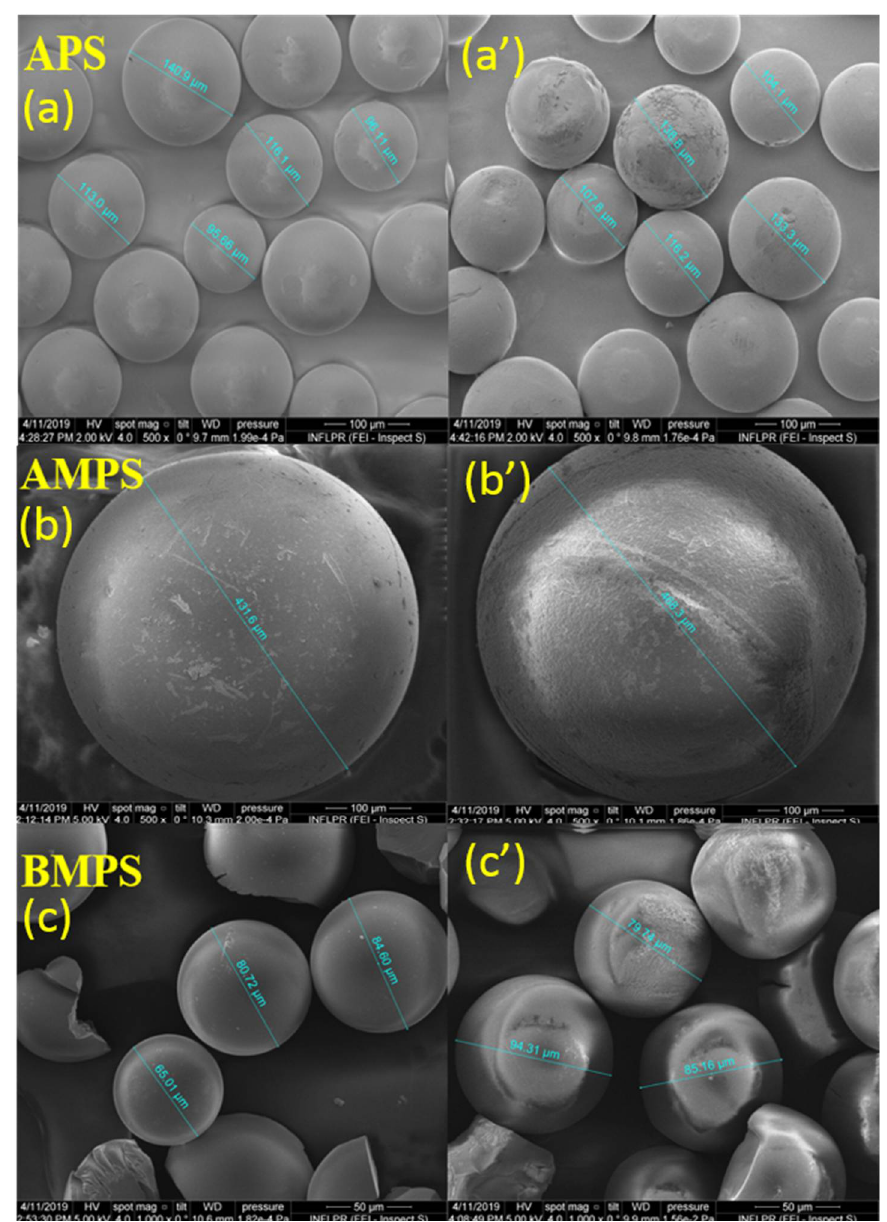
Figure 6. SEM microphotographs of the solid catalysts before ( a ), ( b ), ( c ) and after four cycles of pullulan oxidation reaction ( a’ ), ( b’ ), ( c’ ).